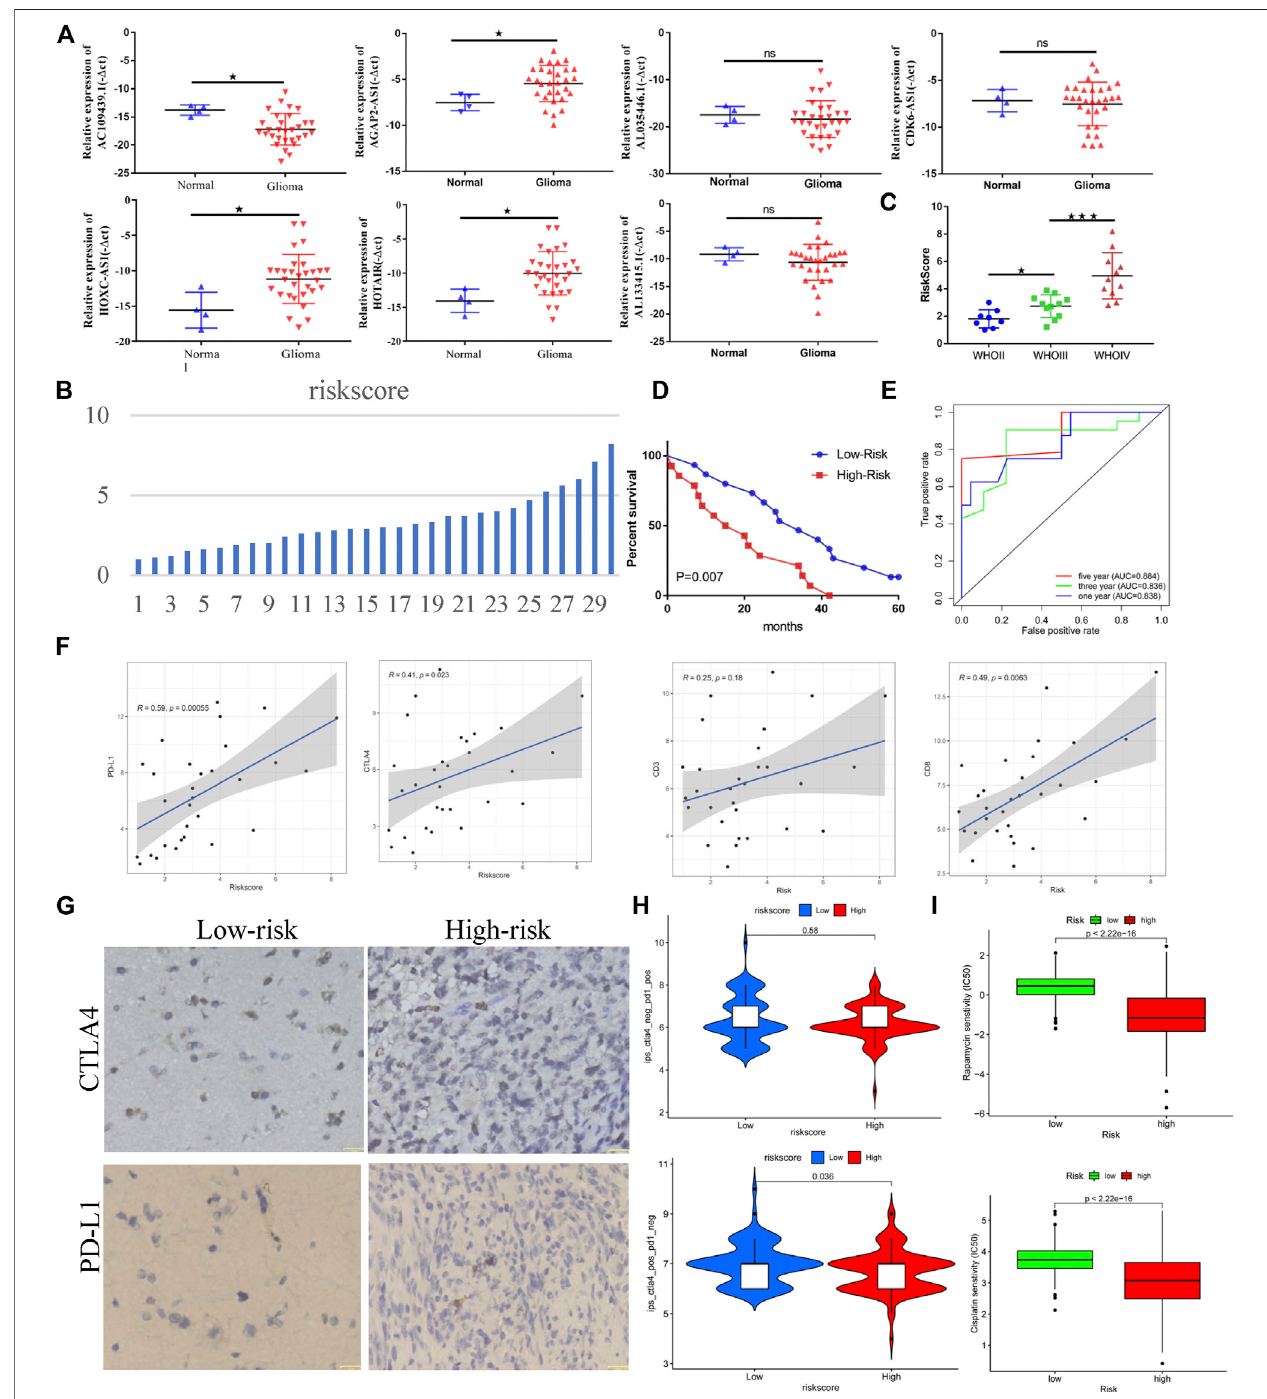
FIGURE10| Genome instability-related lncRNAs are closely related totheclinical prognosisand immunotherapysensitivityofglioma. (A) Differential expression of lncRNAsrelatedtogenomeinstabilityinnormaltissueandgliomas. (B) Distributionofriskscoresof30gliomasamples. (C) RelationshipbetweentheWHOclassi fi cation andriskscore(basedonlncRNArelatedtogenomeinstability)inglioma. (D) Relationshipbetweentheriskscoreandprognosisofpatientswithglioma. (E) Ef fi cacyofrisk score in predicting the prognosis of patients with glioma. (F) Correlation between risk score and immune checkpoint of glioma samples. (G) Immunohistochemical resultsofimmunecheckpointsforthehigh-andlow-riskgroups. (H) Correlationbetweentheriskscoreandimmunotherapysensitivity. (I) Sensitivityofthehigh-andlow- risk groups to chemotherapy drugs.